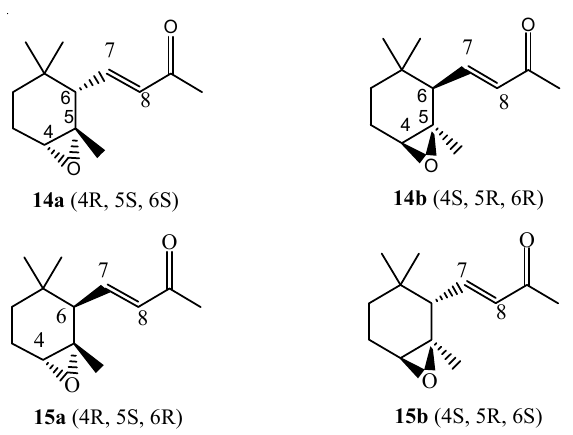
Figure 2. Oxidation products of α -ionone 3